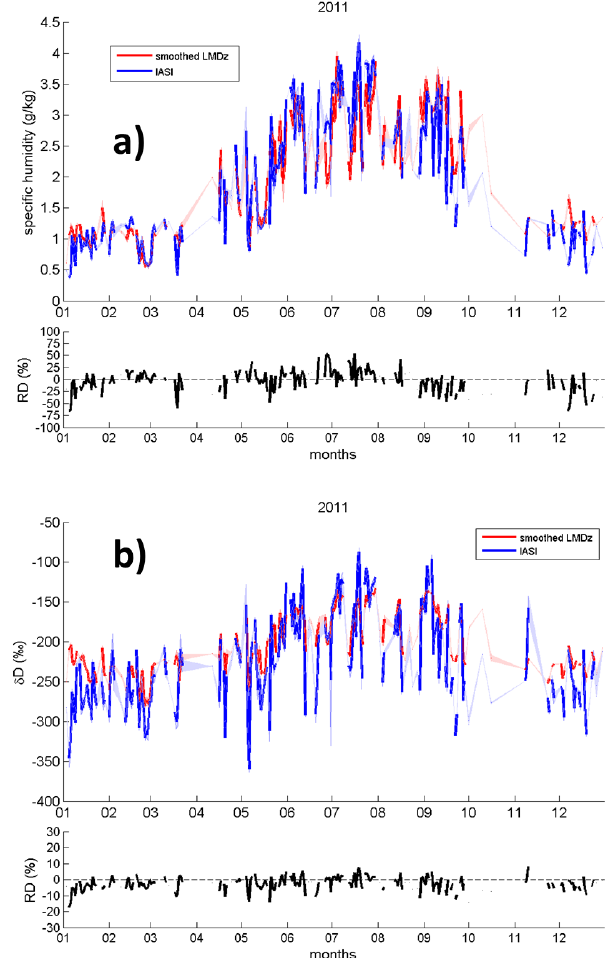
Figure 8. Daily [0–3km] specific humidity (a) and δ D (b) means by IASI (blue curve) and smoothed LMDZ-iso (red curve) for 2011 with a | 1T | > 8K. The shade contour represents the standard de- viation. The relative difference is calculated as: ((IASI-LMDZ- iso)/LMDZ-iso) × 100%. For the RD δ D calculation, δ D is normal- ized by δ D +